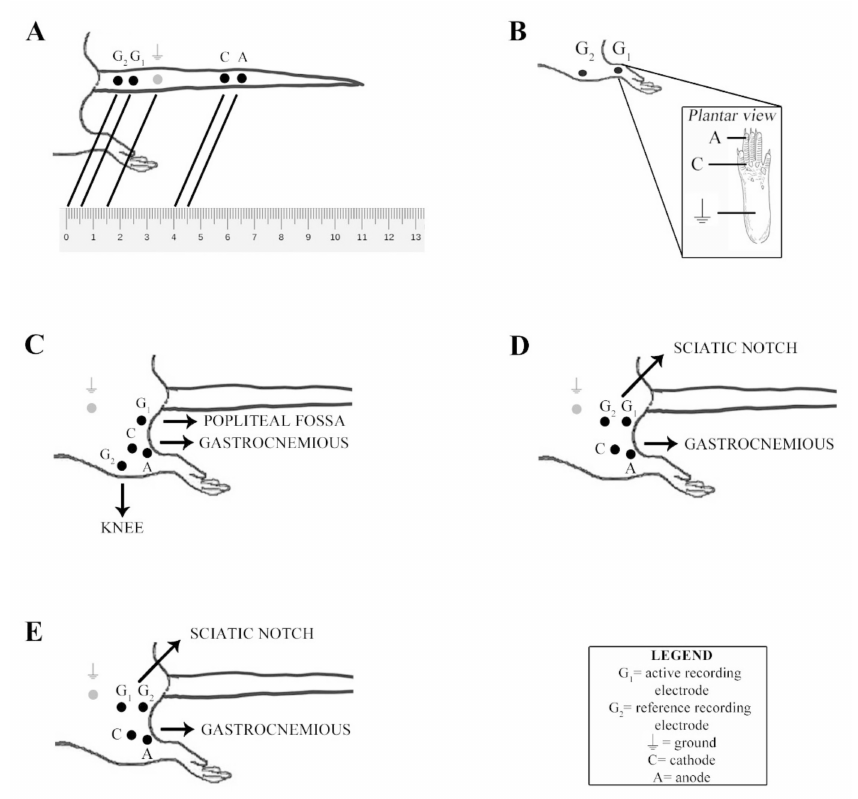
Figure 1. Nerve conduction study (NCS) montage. ( A ) Caudal nerve sensory conduction study (SCS) montage. ( B ) Digital nerve SCS montage. ( C ) Sciatic nerve motor conduction study (MCS) montage at the distal site of stimulation. ( D ) Sciatic nerve MCS montage at the proximal site of stimulation. ( E ) Sciatic nerve F wave